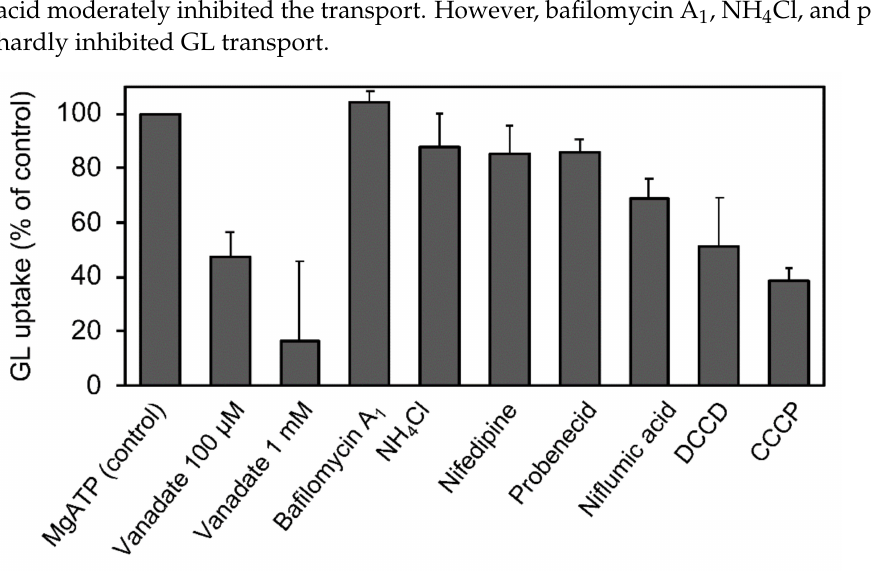
Figure 9. Effect of various transport inhibitors on ATP-dependent GL uptake. Tonoplast vesicles were incubated with 100 µ M GL, and vanadate (1 mM), bafilomycin A 1 (1 µ M), NH 4 Cl (5 mM), nifedipine (100 µ M), probenecid (100 µ M), niflumic acid (100 µ M), DCCD (100 µ M), or CCCP (100 µ M)